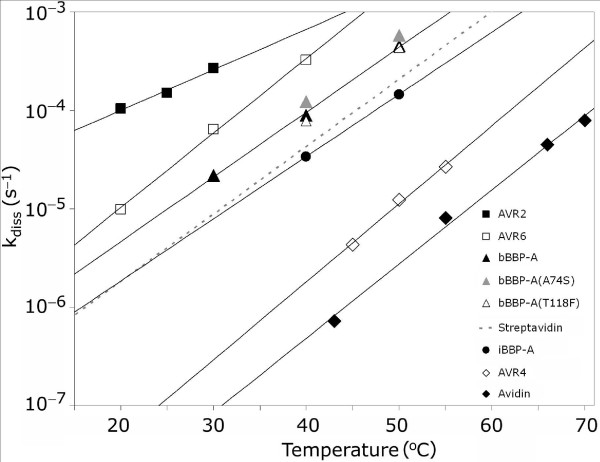
Biotin dissociation analysis. The dissociation of [3H]biotin from various proteins was determined over time. The individual dissociation rates of [3H]biotin measured for bBBP-A (black triangles), bBBP-A(A74S) (grey triangles), bBBP-A(T118F) (white triangles) and iBBP-A (black circles) are shown. Solid lines represent linear fit to data sets. Data measured previously for AVR2 (black rectangles), AVR6 (white rectangles) and AVR4 (white tilted rectangles), all produced in bacteria, are also shown [24, 28]. Data measured for chicken AVD (tilted black rectangles) are presented, too [42]. AVR6 and AVR4 carried the mutations C58S and C122S, respectively, which prevented the formation of intersubunit disulphide bridges [33]. The dissociation rates for streptavidin are shown as a dotted line according to [29].